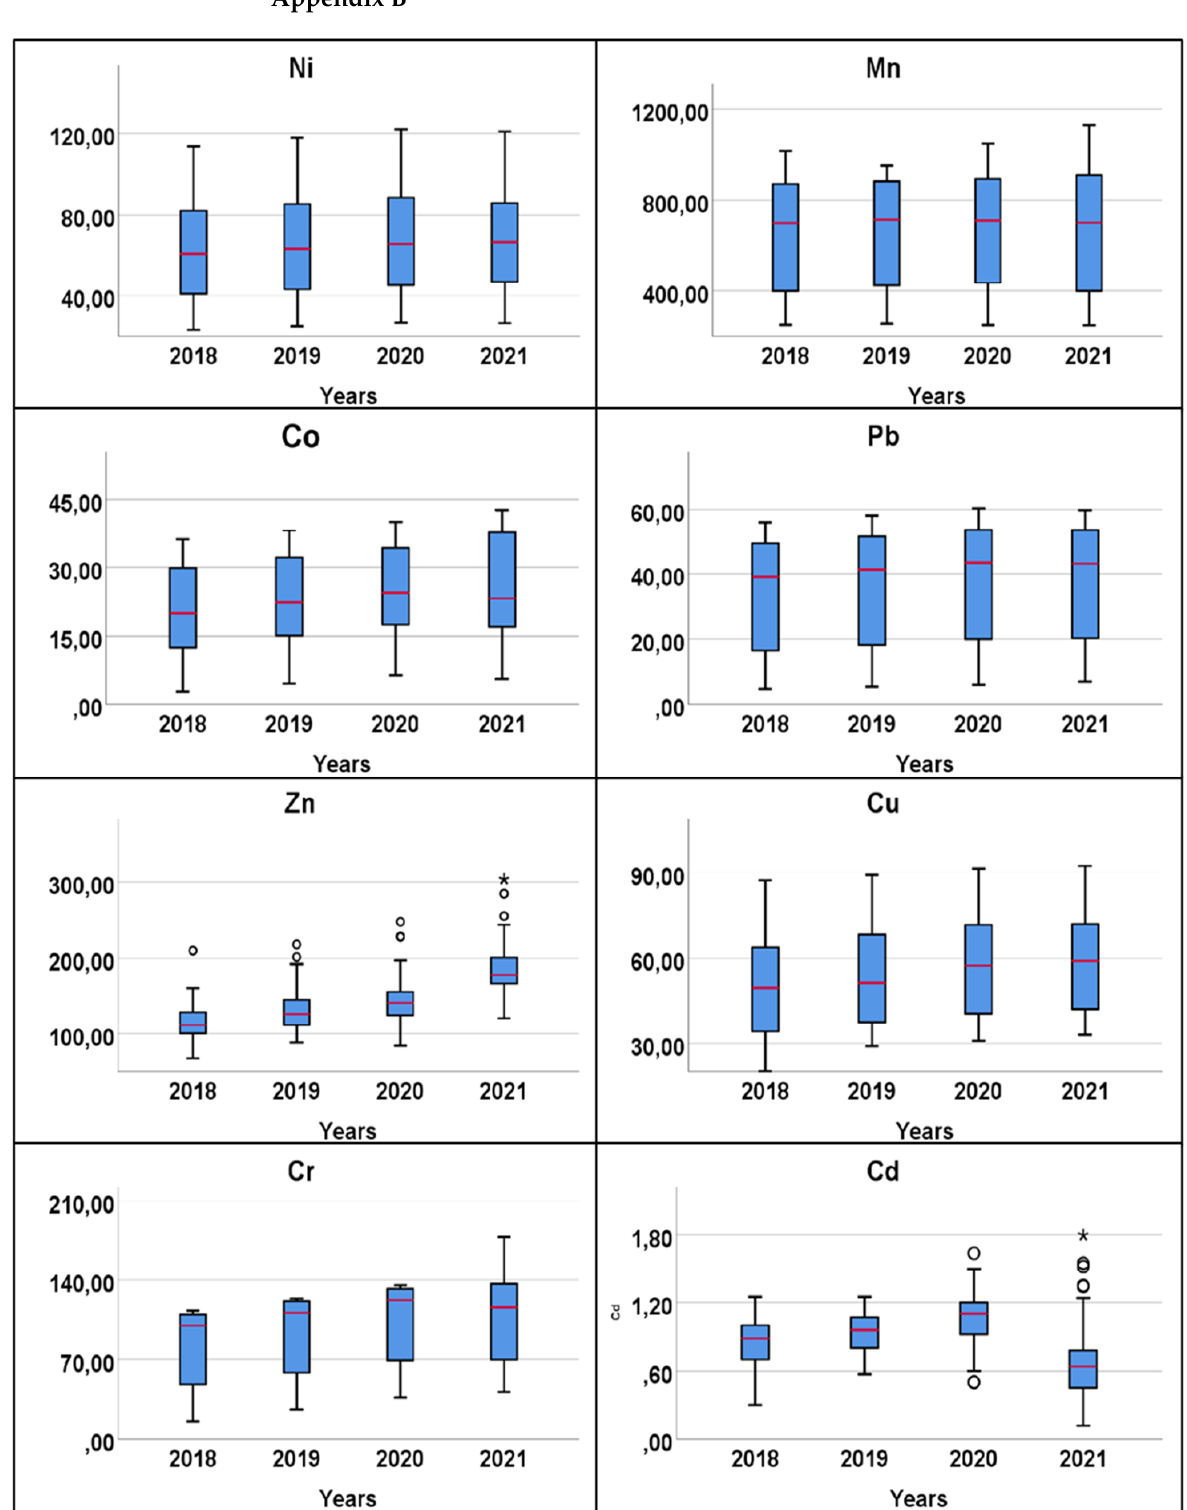
Figure A2. The box plots of the eight HMs and the red lines which indicate the median. The existence of circles and stars indicates that there are outliers, which are values outside the whiskers of the box plot.